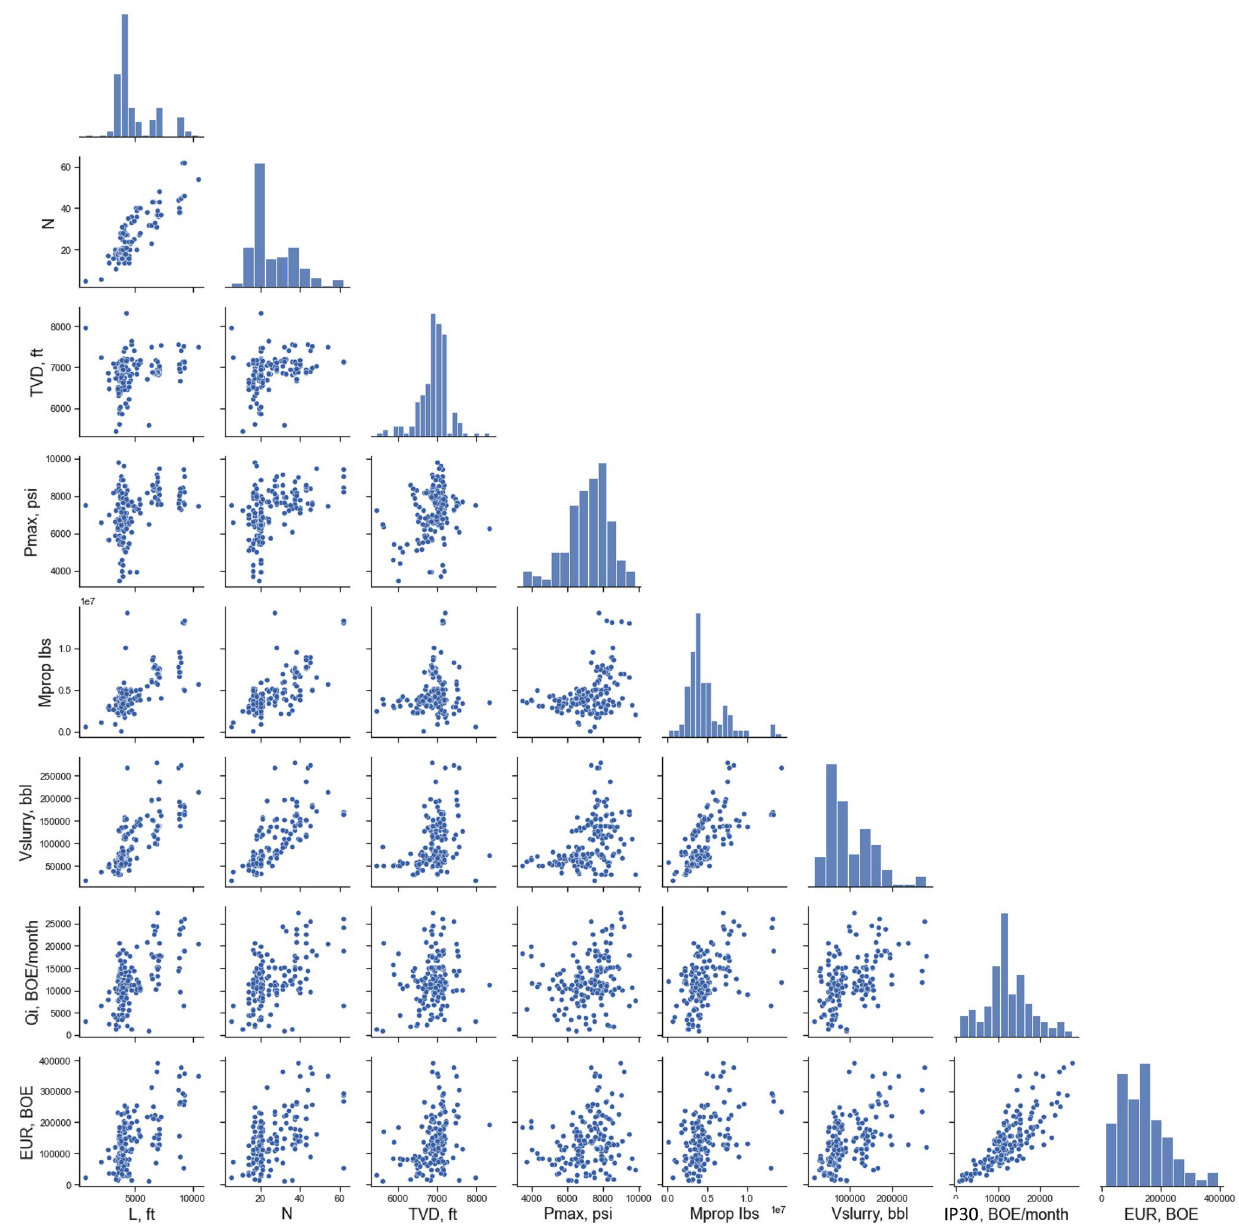
Fig. 1 Matrix plot of the input and output parameters with the diagonal shows the data frequency